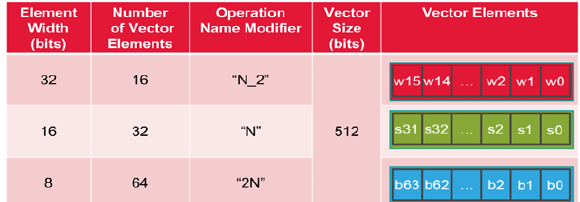
Figure 3. Vision DSP vector register (the illustration is from the Cadence Company technical material). “N_2” corresponds to 16 32-bit signed elements, “N” to 32 16-bit signed elements, and “2N” to 64 8-bit elements.